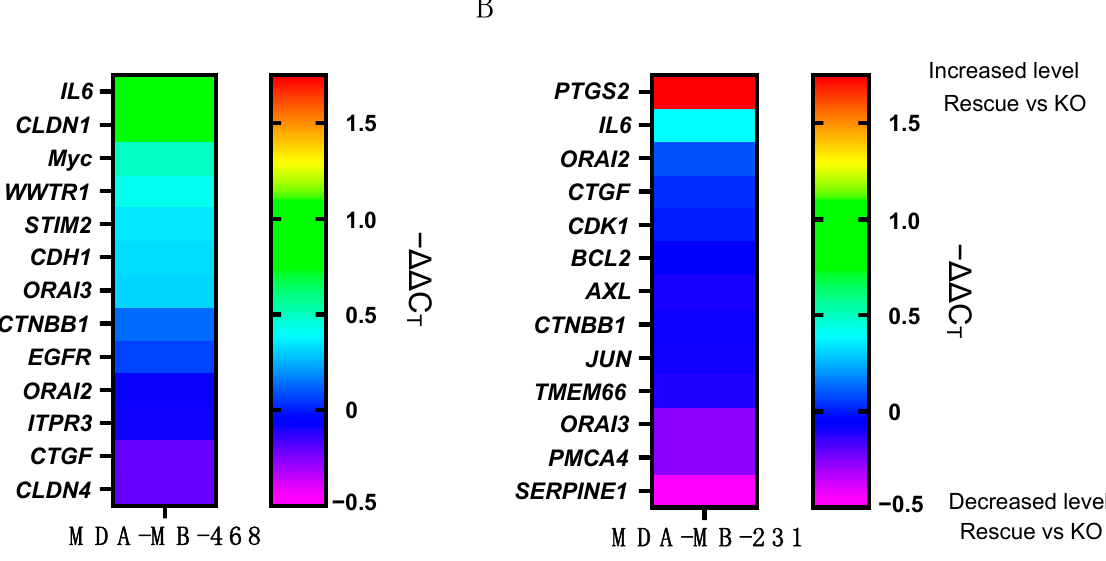
Figure 2. Effect of ORAI1 on gene expression. ( A ) Heatmap representing mRNA − ∆∆ C T of MDA-MB-468 ORAI1 WT rescue compared to MDA-MB-468 ORAI1 knockout cells. Data represent the mean of three independent experiments. ( B ) Heatmap representing mRNA − ∆∆ C T of MDA-MB-231 ORAI1 WT rescue compared to MDA-MB-231 ORAI1 knockout cells. Data represent the mean of three independent experiments.